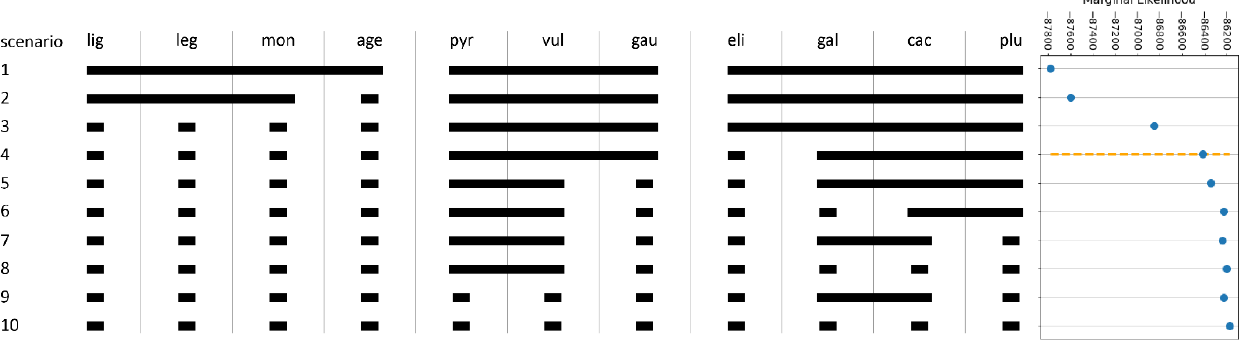
Figure 3. The ten species scenarios (scenarios 1–10) from merging the morpho-species in ascending orders of complexity and the plot of the marginal likelihoods (MLs) against species scenarios. The elbow point of the ML-complexity curve (orange dotted line) is located in scenario 4.